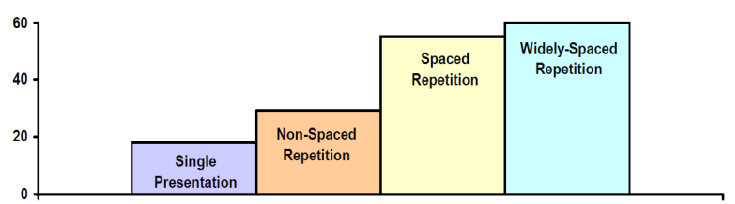
Figure 1: Experiment 1; Source: Dellarosa and Bourne